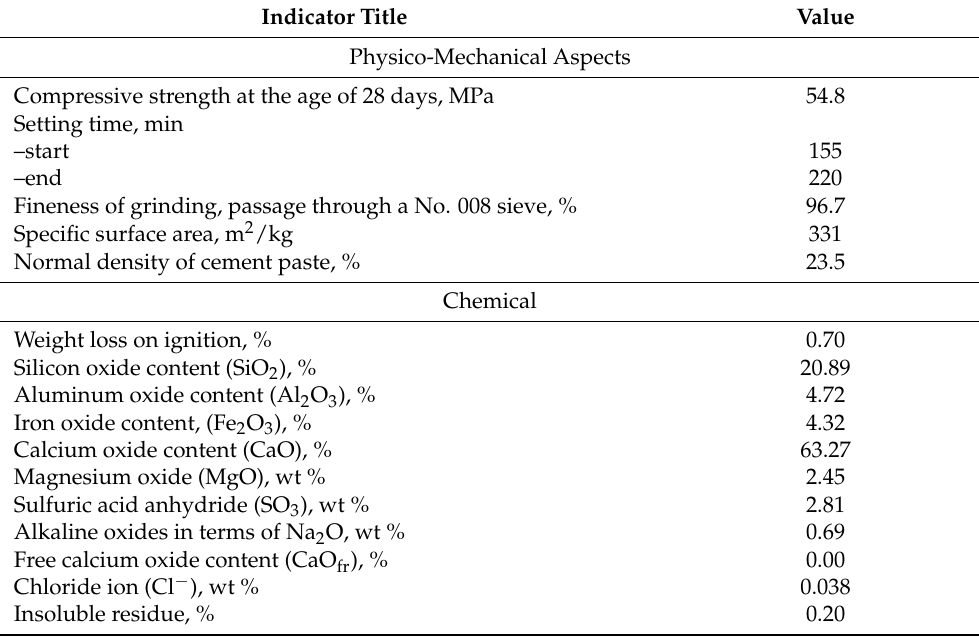
Physical and mechanical characteristics of Portland cement PC 500 D0 and its chemical